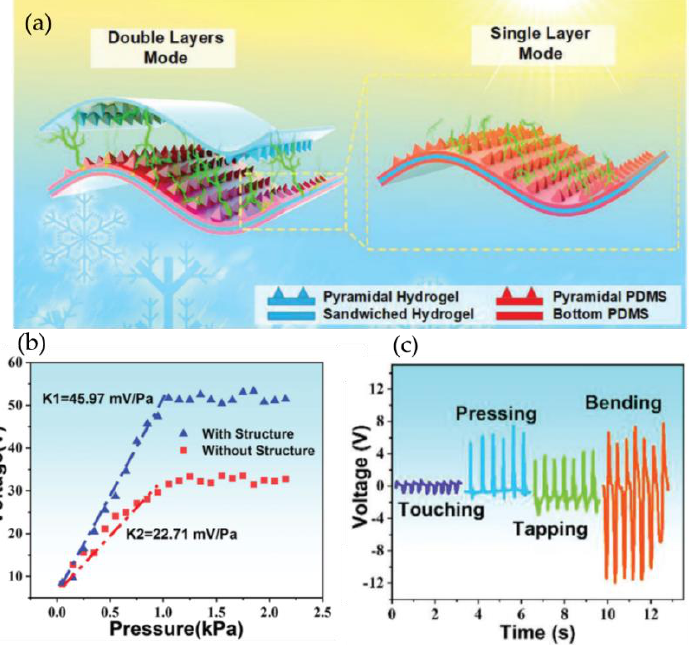
Figure 6. ( a ) Schematic diagram of the DE-THS and SE-THS. ( b ) Open-circuit voltage of both the plain SE-THS and the micro-pyramid-patterned SE-THS varied with different pressure. ( c ) Output signals of DE-THS under touching, pressing, tapping, and bending (reprinted with permission from [68] ).